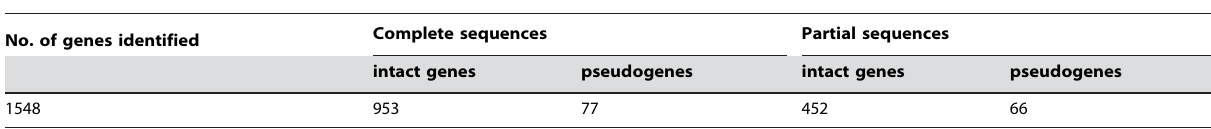
Table 1. Number of opossum OR genes identified in this study.